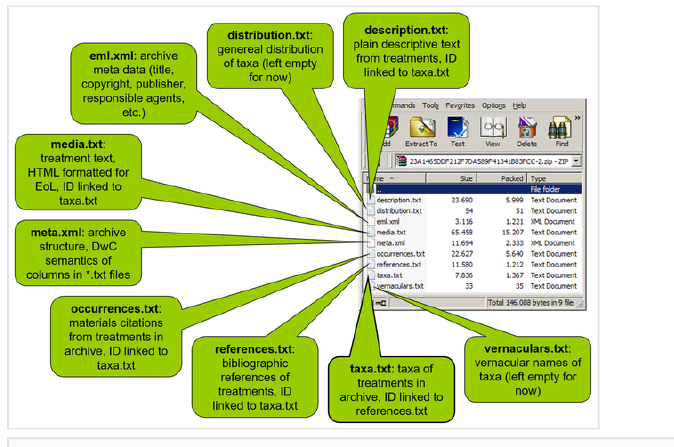
Figure 3. The implementation of Darwin Core Archive in Plazi to transfer treatment data. Observation data described with Darwin Core